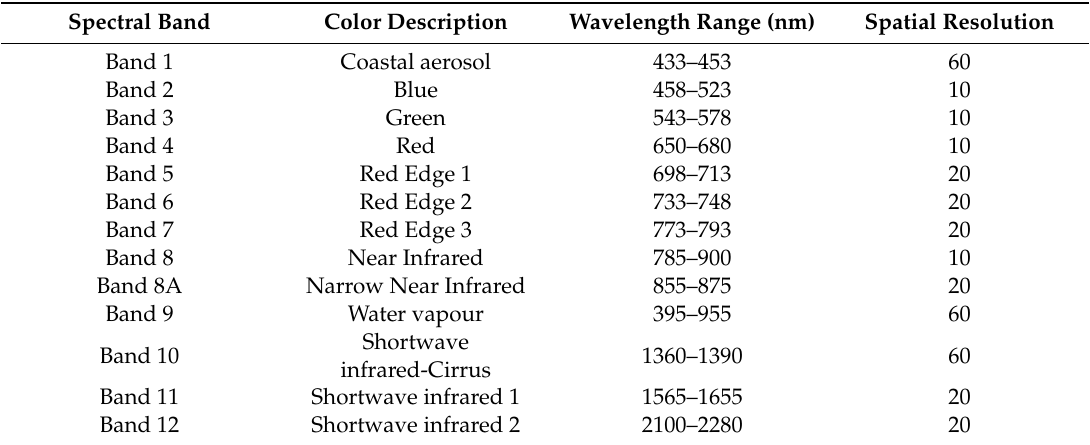
Figure 1. Sentinel 2 images used for the land cover mapping of the study area. Table 1. Spectral and spatial resolution of the multispectral instrument (MSI) instrument onboard Sentinel-2 satellites.